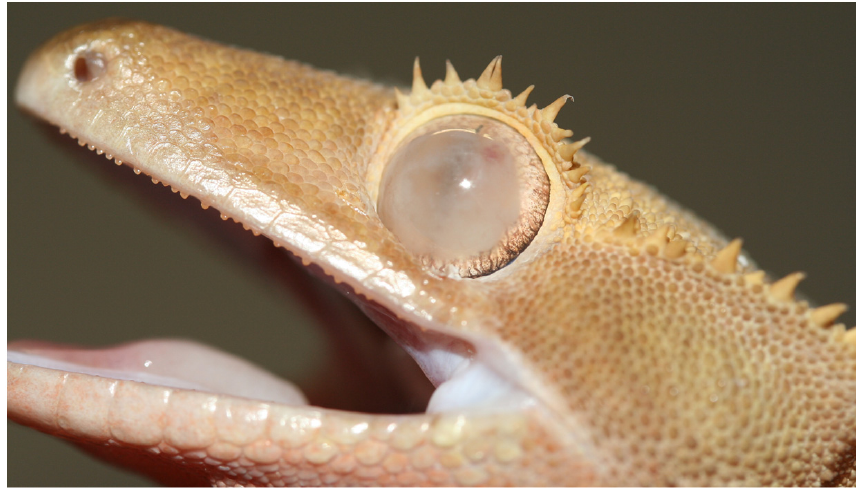
Figure 17. Spectaculitis associated with bacterial infection in a crested gecko ( Correlophus ciliatus ).